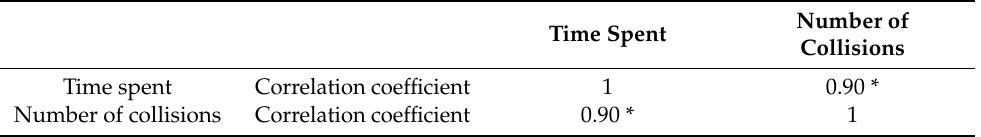
Table 5. Average changes in the number of collisions and time spent were highly correlated, indicating that more than four rehabilitation attempts are